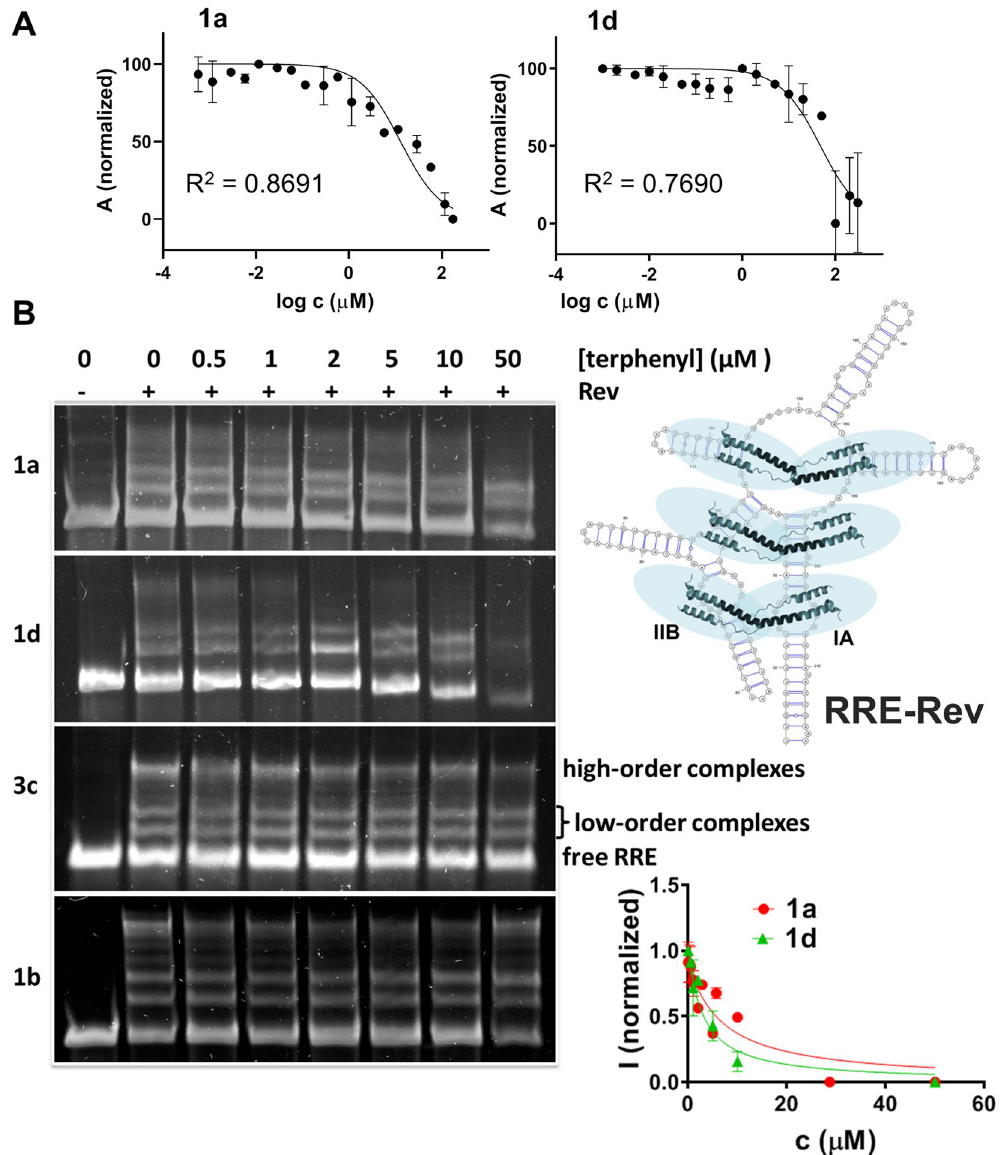
Figure 3. Inhibition of subdomain IIB-Rev 34–50 and full-length RRE–Rev complex formation by 1,4-terphenyl compounds. ( A ) Curves of IIB h -Rev 34–50 inhibition by terphenyls 1a and 1d , as measured by fluorescence anisotropy. ( B ) Inhibition of the RRE-Rev ribonucleoprotein complex by terphenyl compounds, analysed by EMSA experiments. The gel lanes contained 78 nM RRE, 1.32 μ M Rev (marked with + ) and the specified concentrations of compound 1a , 1d , 3c and 1b . The image shows on the right a schematic representation of the RRE-Rev ribonucleoprotein, with the location of the main Rev binding site in subdomain IIB indicated and the Rev monomers represented with ribbons and blue ovals, together with plots of high-order RRE-Rev band intensity as a function of terphenyl 1a and 1d concentration; the error bars represent the standard deviation of three independent